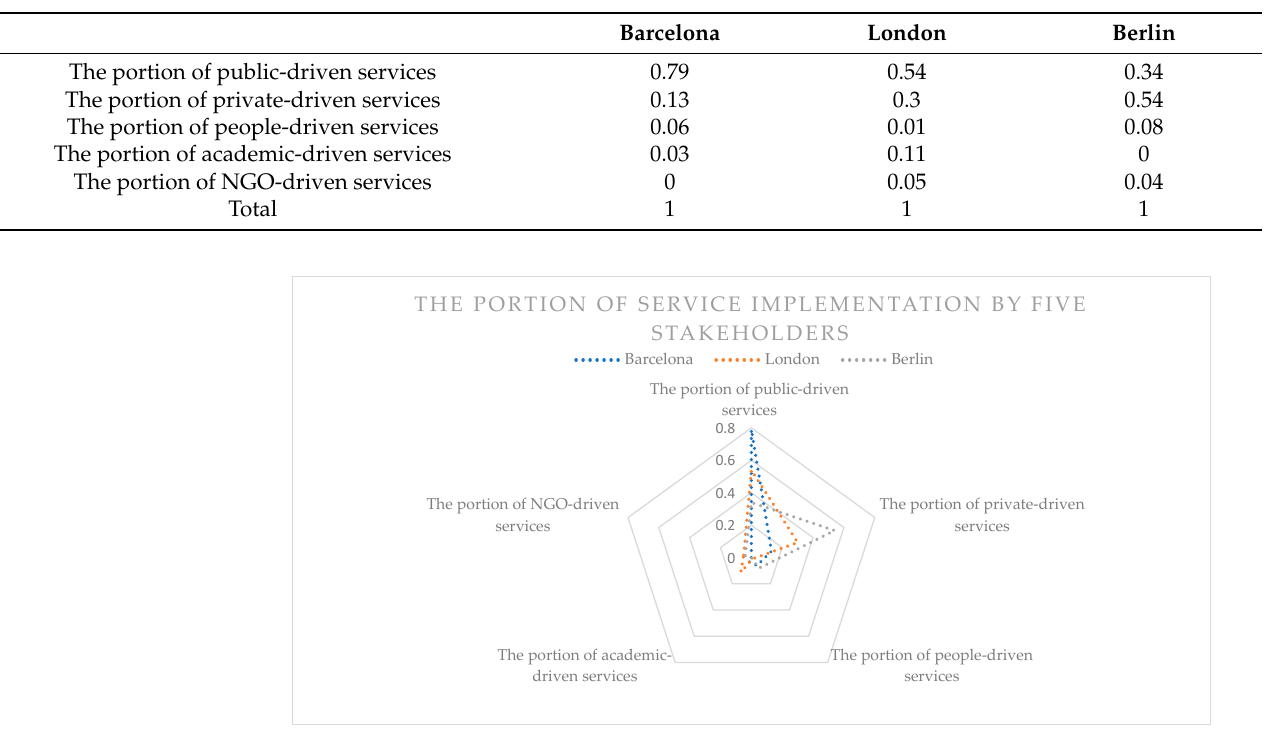
Figure 6. The portion of service implementation by five stakeholders.